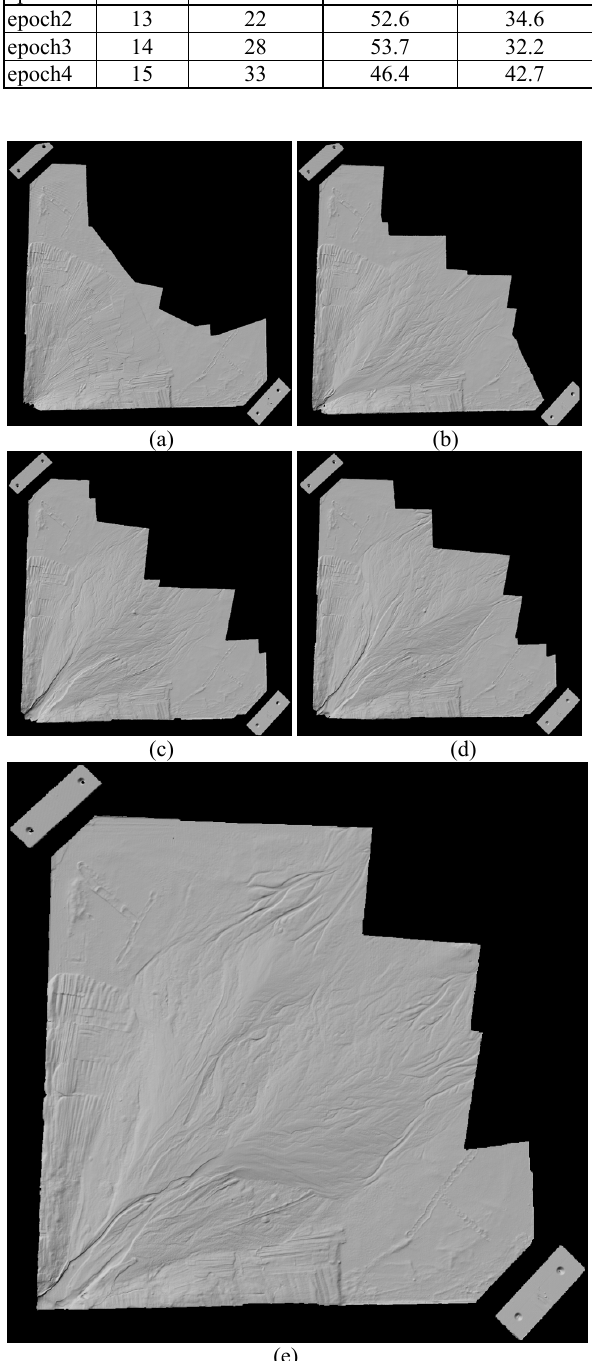
Figure 3. DEMs of the epoch0 (a), epoch1 (b), epoch2 (c), epoch3 (d), and epoch4 (e). Once the point clouds of each epoch are co-registered, they are re-sampled into a DEM with using the SCOP++ version